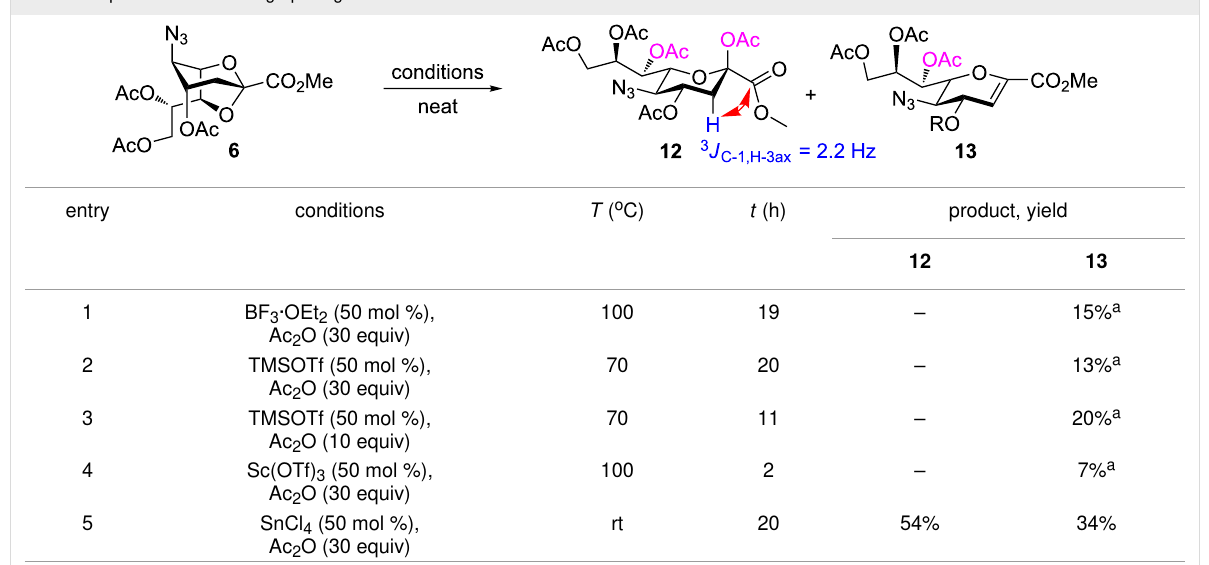
Table 1: Optimization of the ring-opening reaction of 6